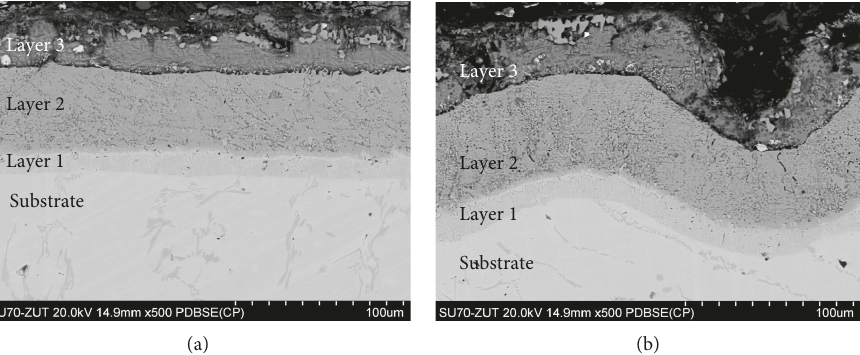
Figure 2: Microstructure (BEI) of Al-Si coating on sample (a) number 16 (surface after grinding), (b) with a rough cast surface (technological parameters in both cases: 900 ° C, 7.5h, Al/Si � 9; central point of the